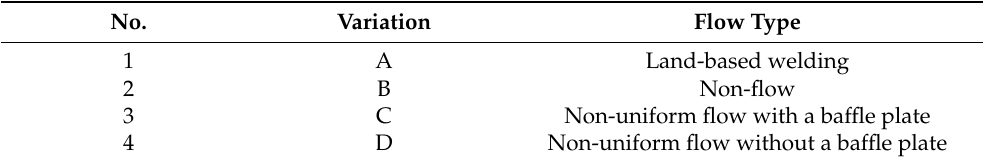
Table 3. Research variables on flow types.